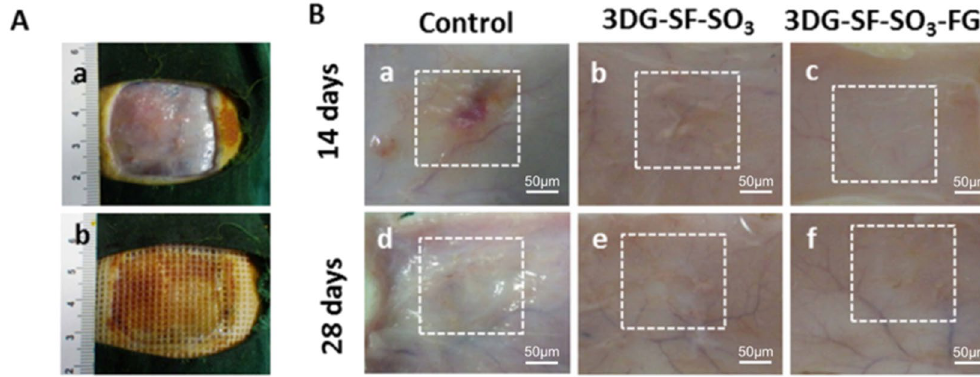
Figure 4. 3DG-SF-SO 3 -FGF scaffolds were applied to full-thickness skin wounds and compared to wounds treated with petroleum gauze (control) or 3DG-SF-SO 3 scaffolds. ( A ) Micrographs of animal surgery (a,b). ( B ) Gross observation of angiogenesis within newly formed tissues of healing wounds at day 14 and day 28 post- surgery. Scale bars, 50 μ